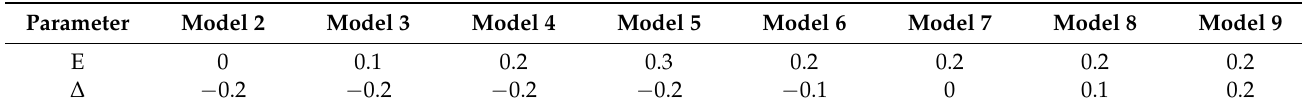
Table 2. Anisotropic parameters of different models.